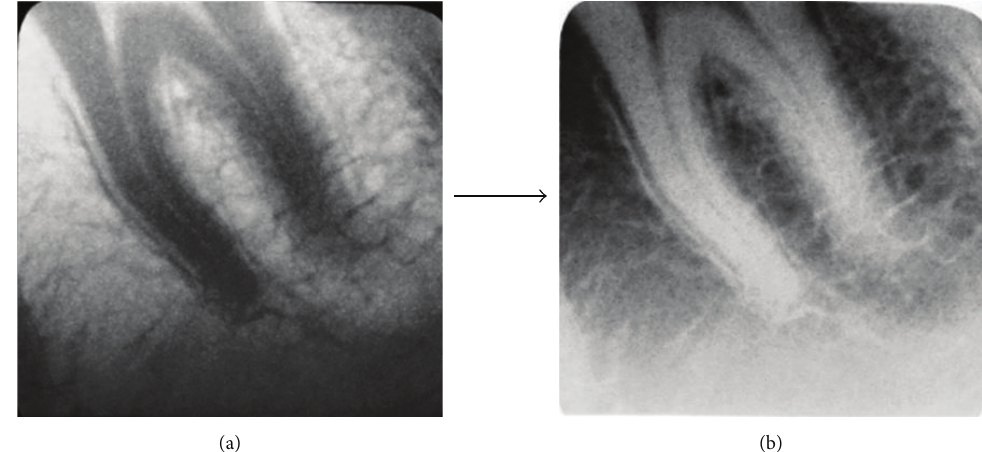
Figure 2: (a) Molar tooth raw positive image obtained at 0.2 mA and 1/30 camera shutter (0.03 seconds) with collimation and (b) negative